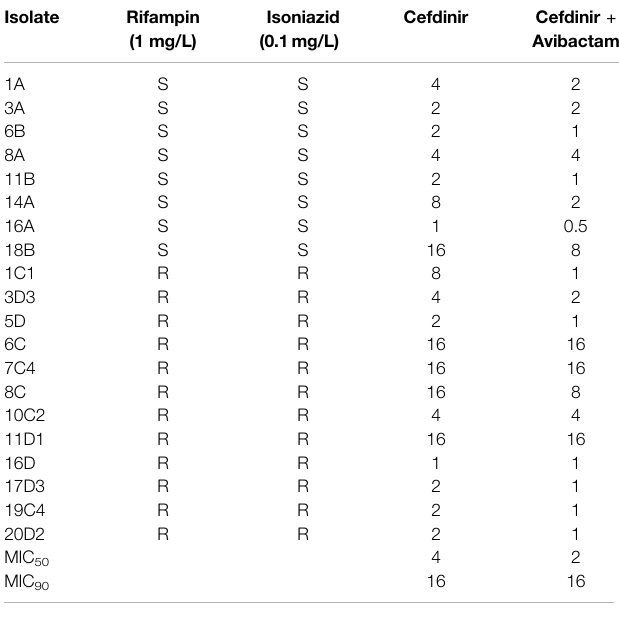
TABLE 1 | Cefdinir MIC of drug susceptible and MDR-TB isolates with or with combination of avibactam at 15 mg/L. Isolate Rifampin (1 mg/L)